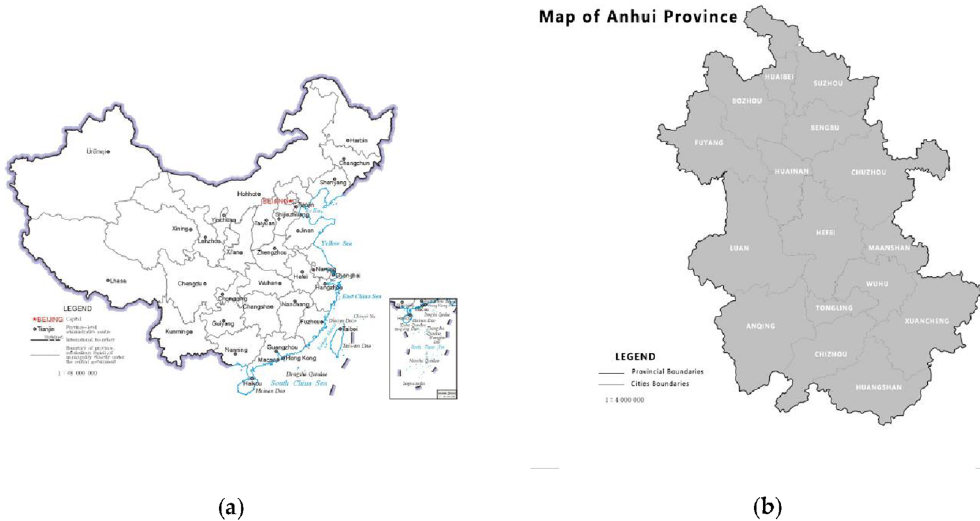
Figure 1. ( a ) The geographical location of China. Source: Obtained from http://o. south gis. com/ news/ detail/ 6028; ( b ) The geographical location of Anhui Province. Source:Obtained from http:// zrzyt. ah. gov. cn/ ztlm/ ahsbz dtfw/ index.